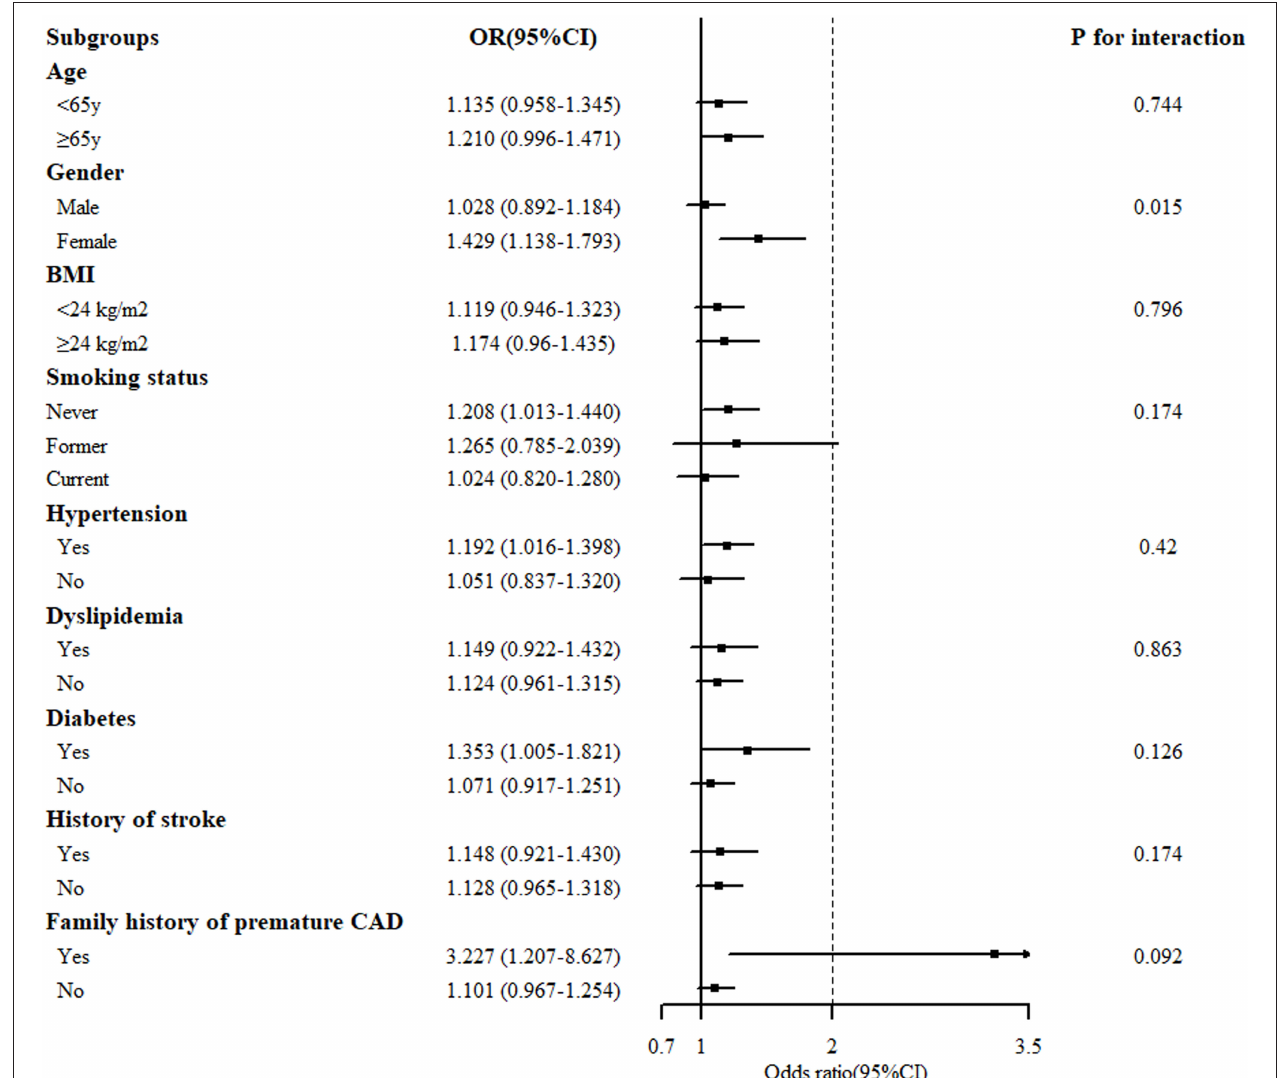
FIGURE 2 | Stratified analysis of the association [odds ratio ( OR ) (95% CI )] between the circulating BHB level (per 1-SD increment) and the severity of coronary artery lesion. Values are adjusted for age, gender, smoking status, obesity or overweight, hypertension, dyslipidemia, diabetes, stroke, and family history of premature CAD, stratifying factors excepted. The p < 0.05 considered statistically